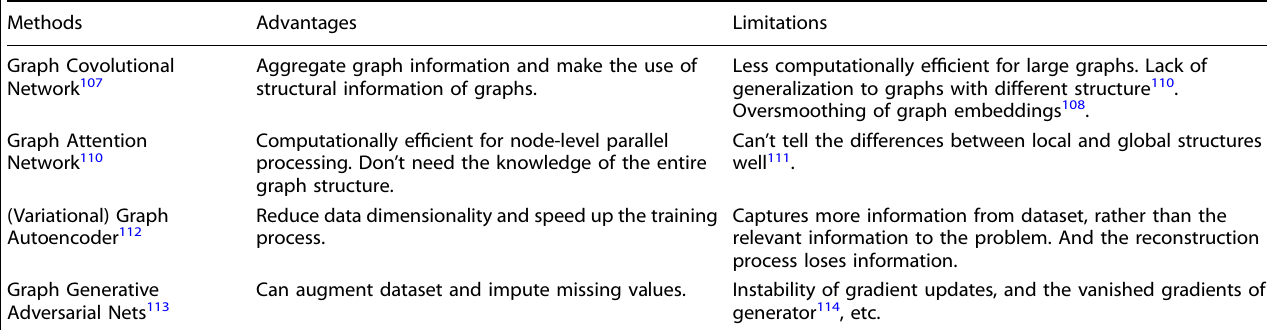
Table 4. Graph learning